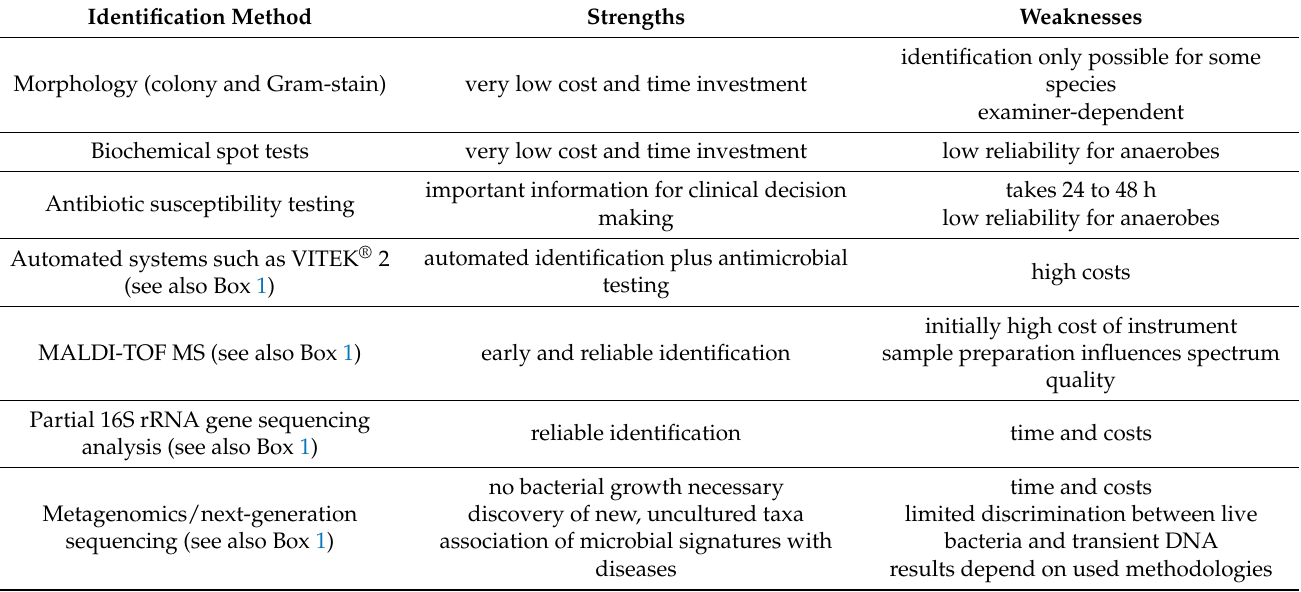
Table 2. Strengths and weaknesses of different methods for bacterial